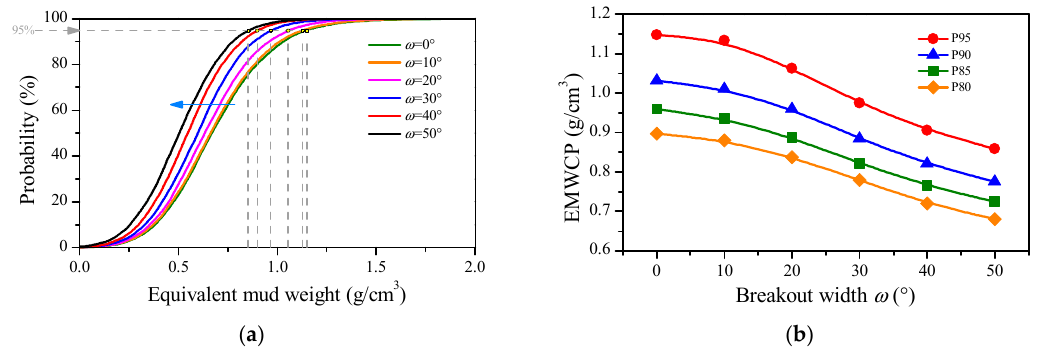
Figure 9. Influence of breakout on EMWCP. ( a ) The cumulative probability of EMWCP; ( b ) EMWCP varies with breakout width.